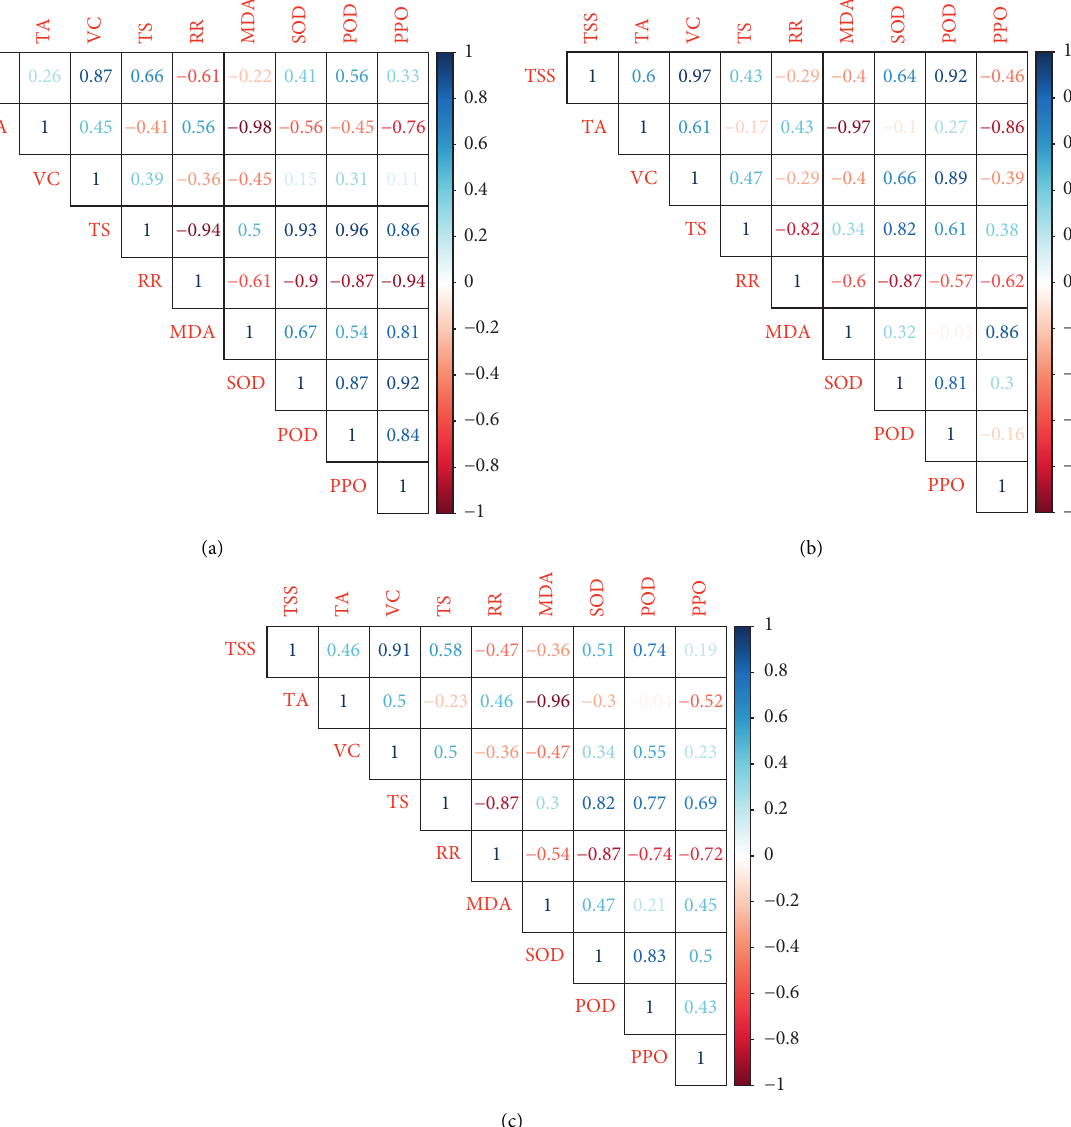
Figure 6: Correlation matrix based on Pearson’s correlation coefficients among the biochemical quality parameters during storage. (a) The correlation matrix for HWD-treated fruits, (b)) the matrix for control group, and (c)) the overall average of all fruits (TA: titratable acidity; MDA: malondialdehyde content; VC: vitamin C; TSS: total soluble solids; PPO: polyphenoloxidase; POD: peroxidase; SOD: superoxide dismutase; RR: respiration rate; TS: total sugar). Positive correlations are displayed in blue and negative correlations in red while color intensity is proportional to the correlation